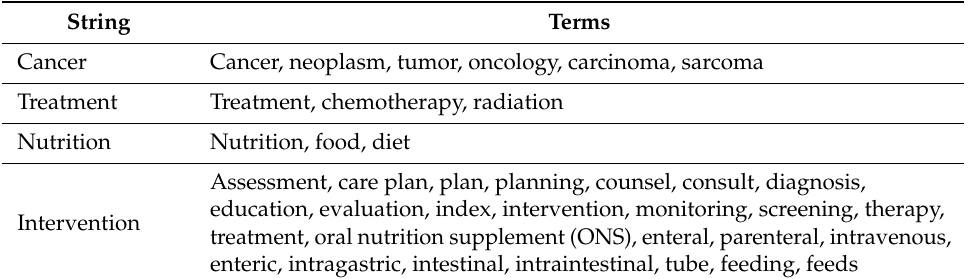
Table 1. Key search terms to identify studies involving early incorporation of nutrition interventions as a component of cancer therapy.